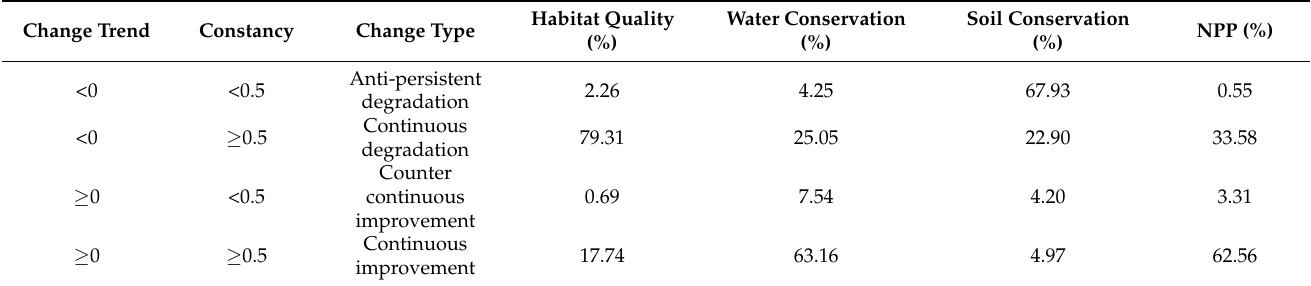
Table 4. Persistence of changes in the ecosystem of the Yangtze River Delta urban agglomeration from 1980 to